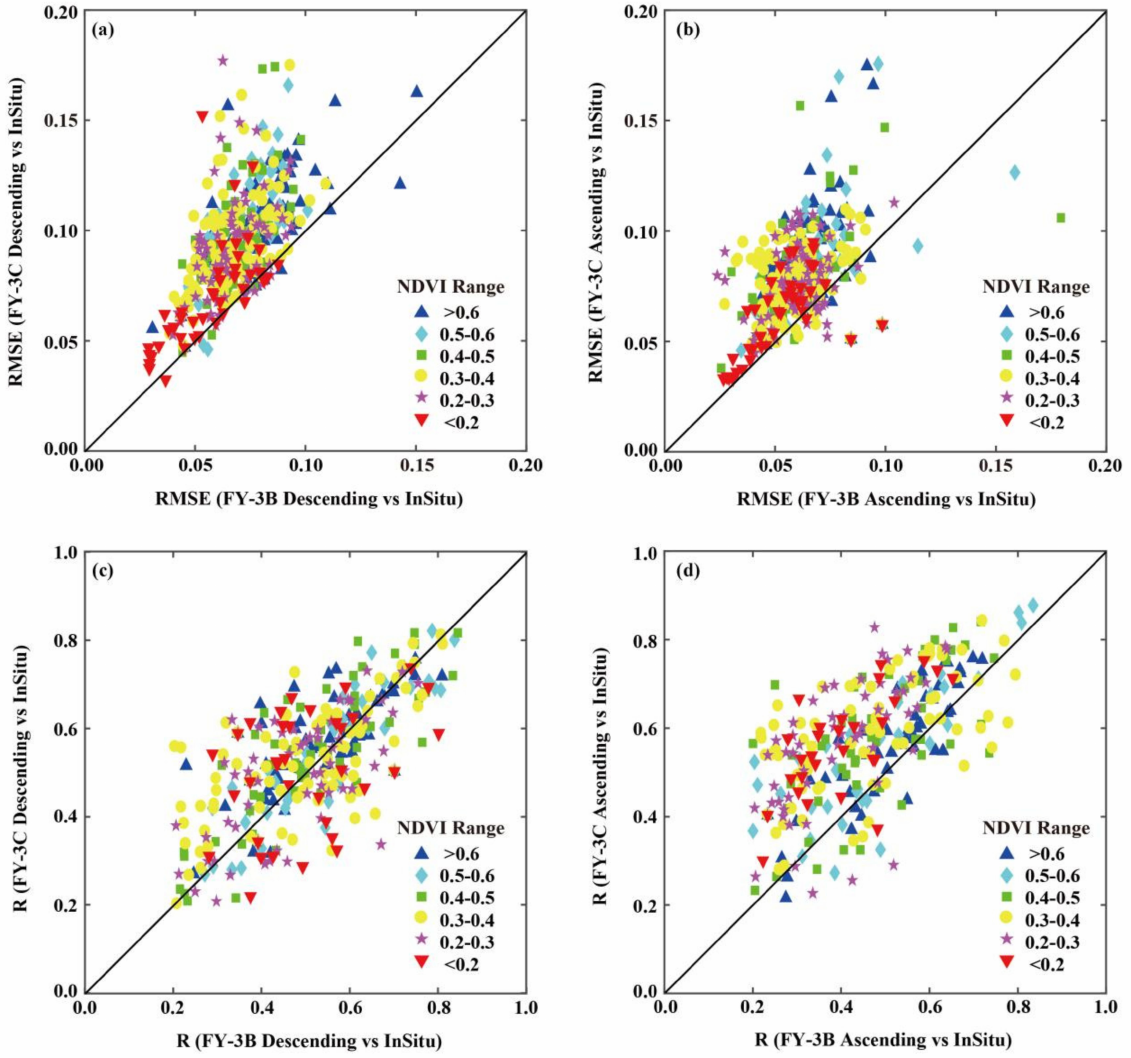
Figure 6. Scatter plots of the FY-3B and FY-3C SM datasets comparisons with the in situ observations across different NDVI ranges. The x-axes show the evaluations of FY-3B with in situ measurements and y-axes show for FY-3C ( a ) a comparison of RMSE of descending data (unit: m 3 m − 3 ); ( b ) a comparison of RMSE of ascending data (unit: m 3 m − 3 ); ( c ) a comparison of correlation coefficient of descending data; ( d ) a comparison of correlation coefficient of ascending